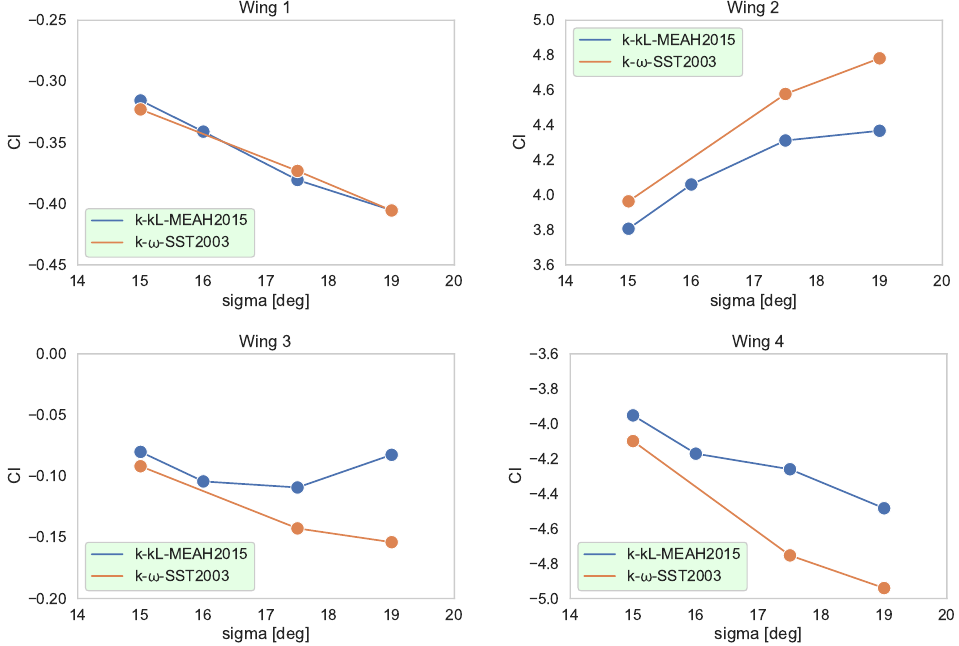
Figure 7. Rolling moment coefficient contributions of wing and fins; M = 0.85, Re d λ = 45°.